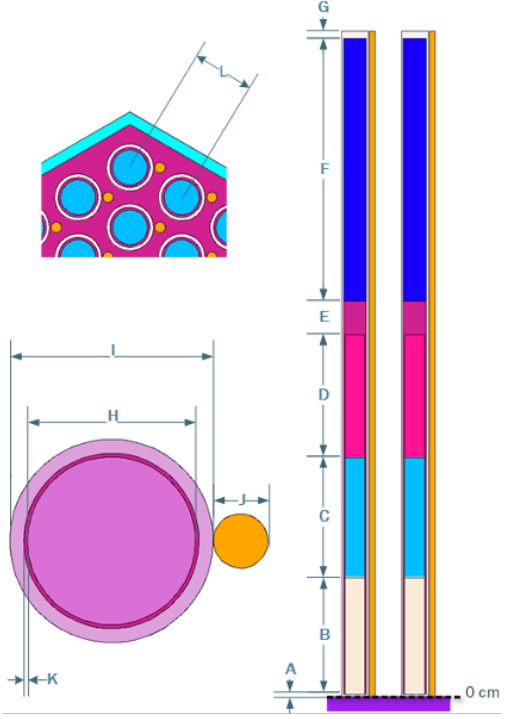
Figure 2. EBR-II driver rod [1]. The driver rod consisted of three fuel slugs (B, C, D), sodium bond (E), and gas plenum